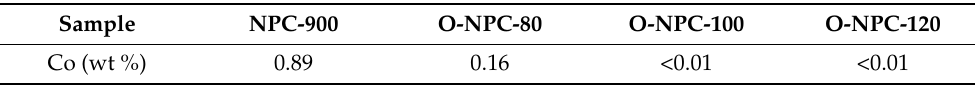
Figure 1. XRD patterns of ( a ) the precursor ZIF-67. ( b ) NPC-900 and O-NPC-T. ( c ) FT-IR spectra of ZIF-67, NPC-900 and O-NPC-T. ( d ) Raman spectra of NPC-900 and O-NPC-T. ( e ) N adsorp- tion–desorption isotherms of NPC-900 and O-NPC-T at 77K. ( f ) Pore size distribution of NPC-900 and O-NPC-T. Table 1. Determination of Co content in catalysts by ICP-MS.